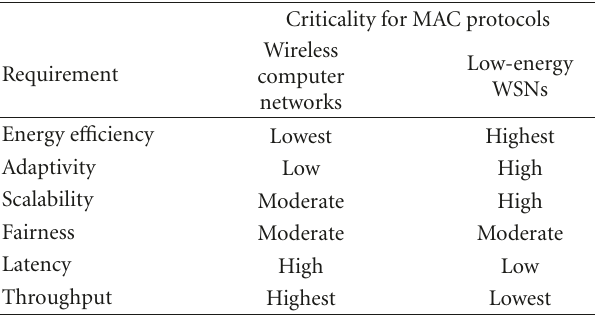
Table 1: Opposite MAC requirements for wireless computer networks and low-energy